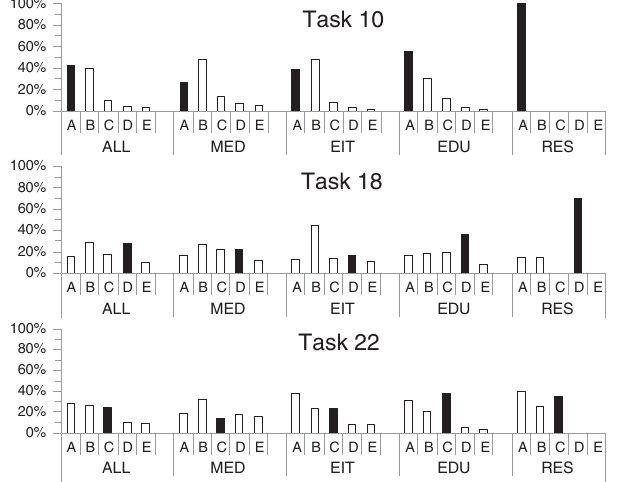
FIG. 5. The students ’ responses to the tasks grouped by the kinetic energy of gas molecules concept concerned. For a detailed description see Fig.